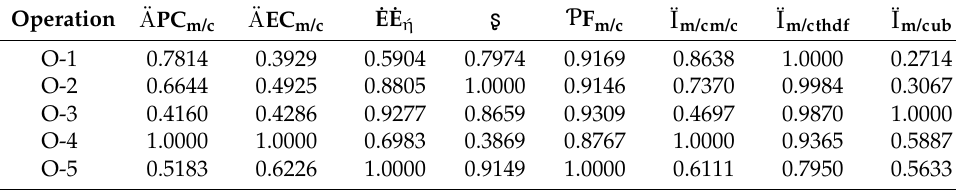
Table A1. Normalized decision matrix (entropy method).